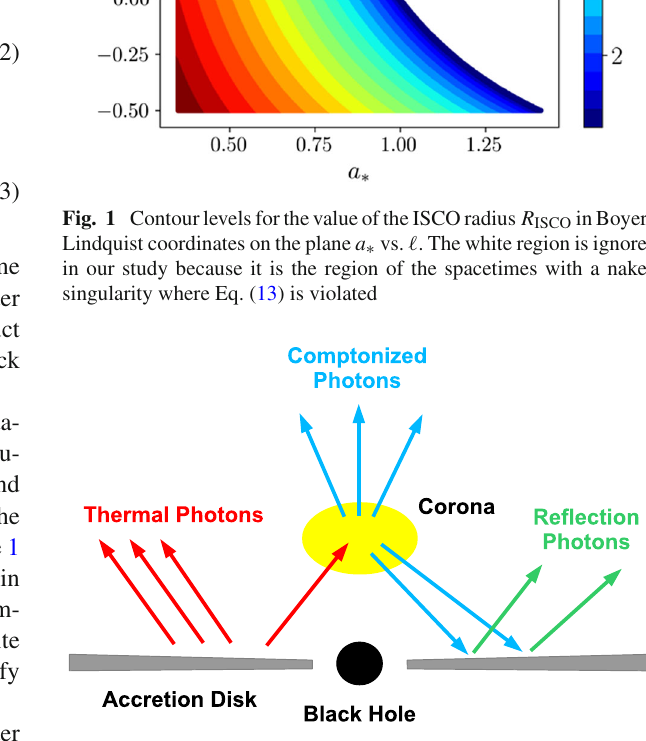
Fig. 2 Disk-coronamodel:theelectromagneticspectrumofthesystem is characterized by a multi-temperature blackbody component from the colddisk,aComptonizedspectrumfromthehotcorona,andareflection spectrum from the disk. Figure from Ref.